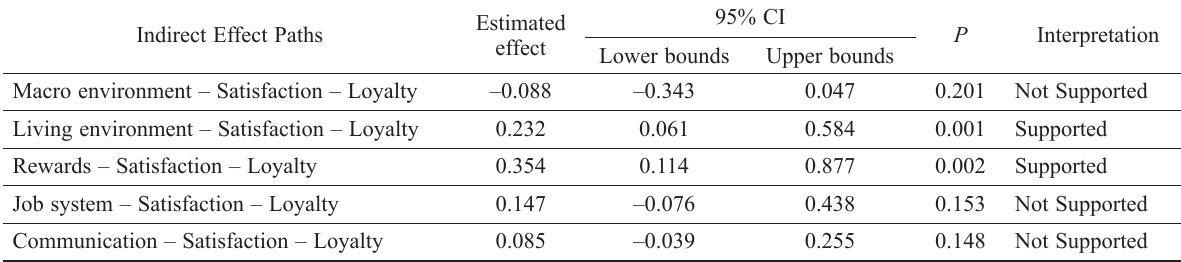
Table 4. Indirect effects and 95% confidence intervals for the final